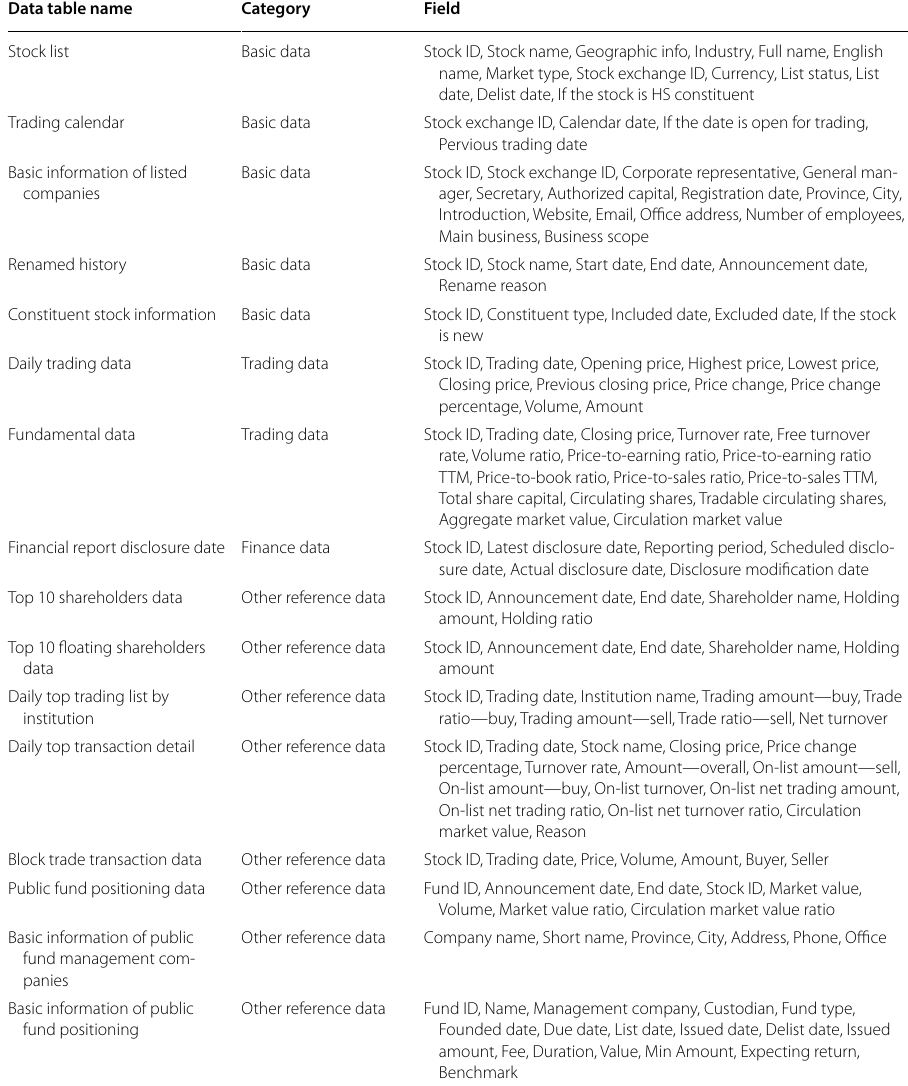
Table 1 Dataset overview table with different categories and subsets of